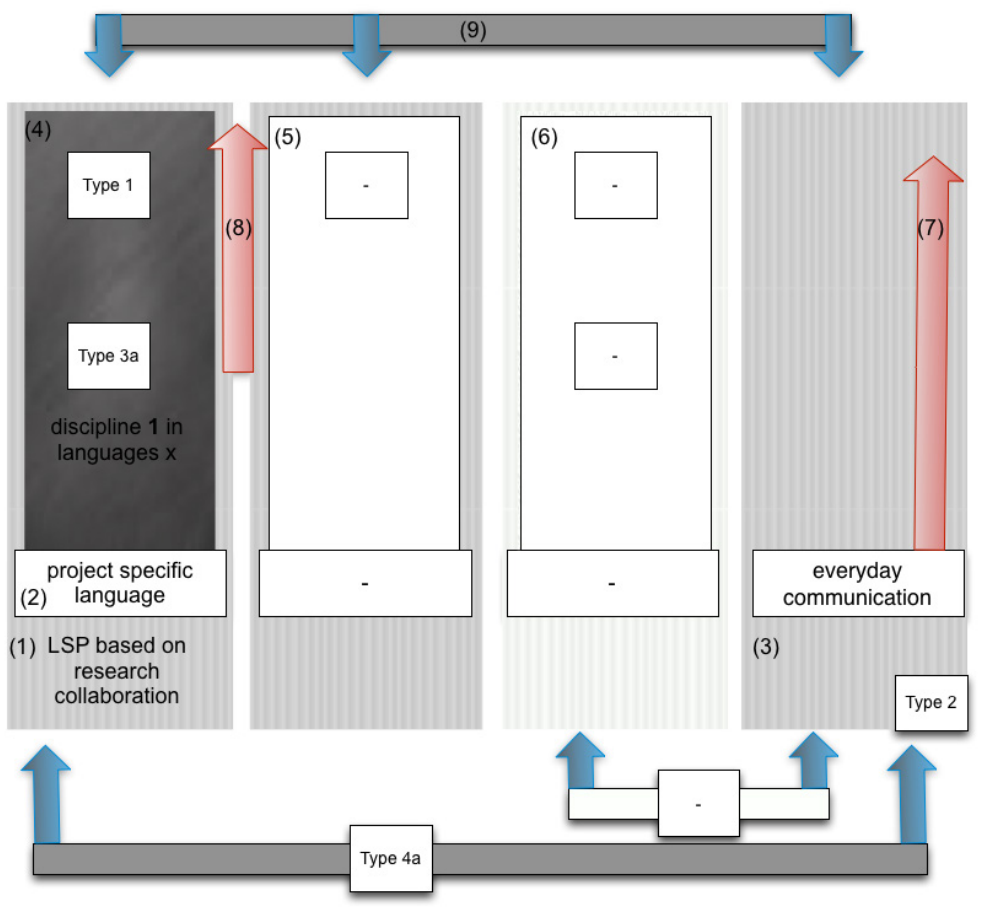
Fig 9: intradisciplinary research project in the data collection